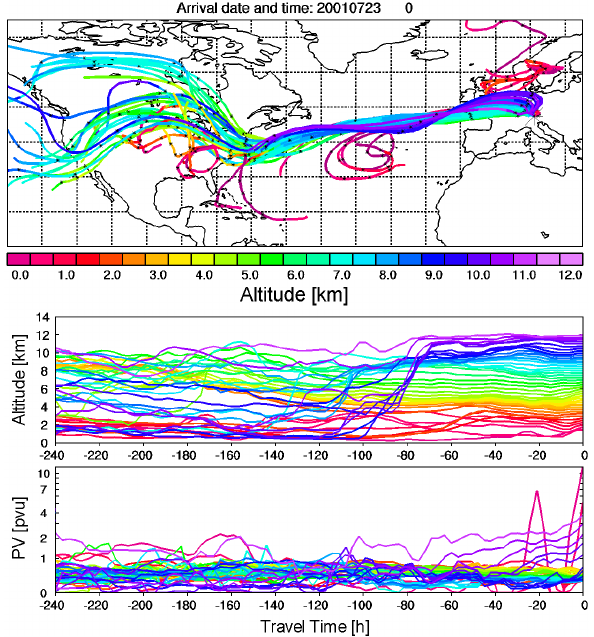
Fig. 14. Ten-day FLEXTRA backward trajectories initiated above Garmisch-Partenkirchen on 23 July 2001, 01:00CET (correspond- ing to labels 1 and 2 in Fig. 13); the colour code in the upper panel describes the altitude at a given time. In the lower two panels it indi- cates the altitude at the location of Garmisch-Partenkirchen ( t = 0). The asterisks on the individual trajectories mark the 00:00UTC po- sitions.